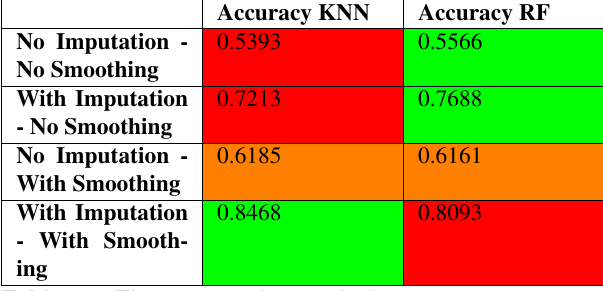
Table 4. The comparison of the accuracy scores, achieved from the test data validation for the KNN and Random Forest